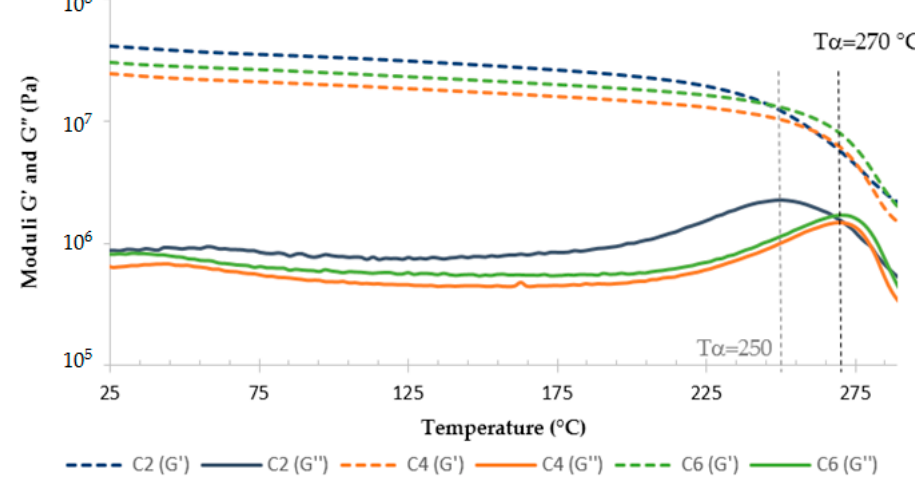
Figure 19. Rheological analyses of TETM/DDS/expandable microspheres foam cured according to various cure cycles, with a heating rate of 3 °C/min.